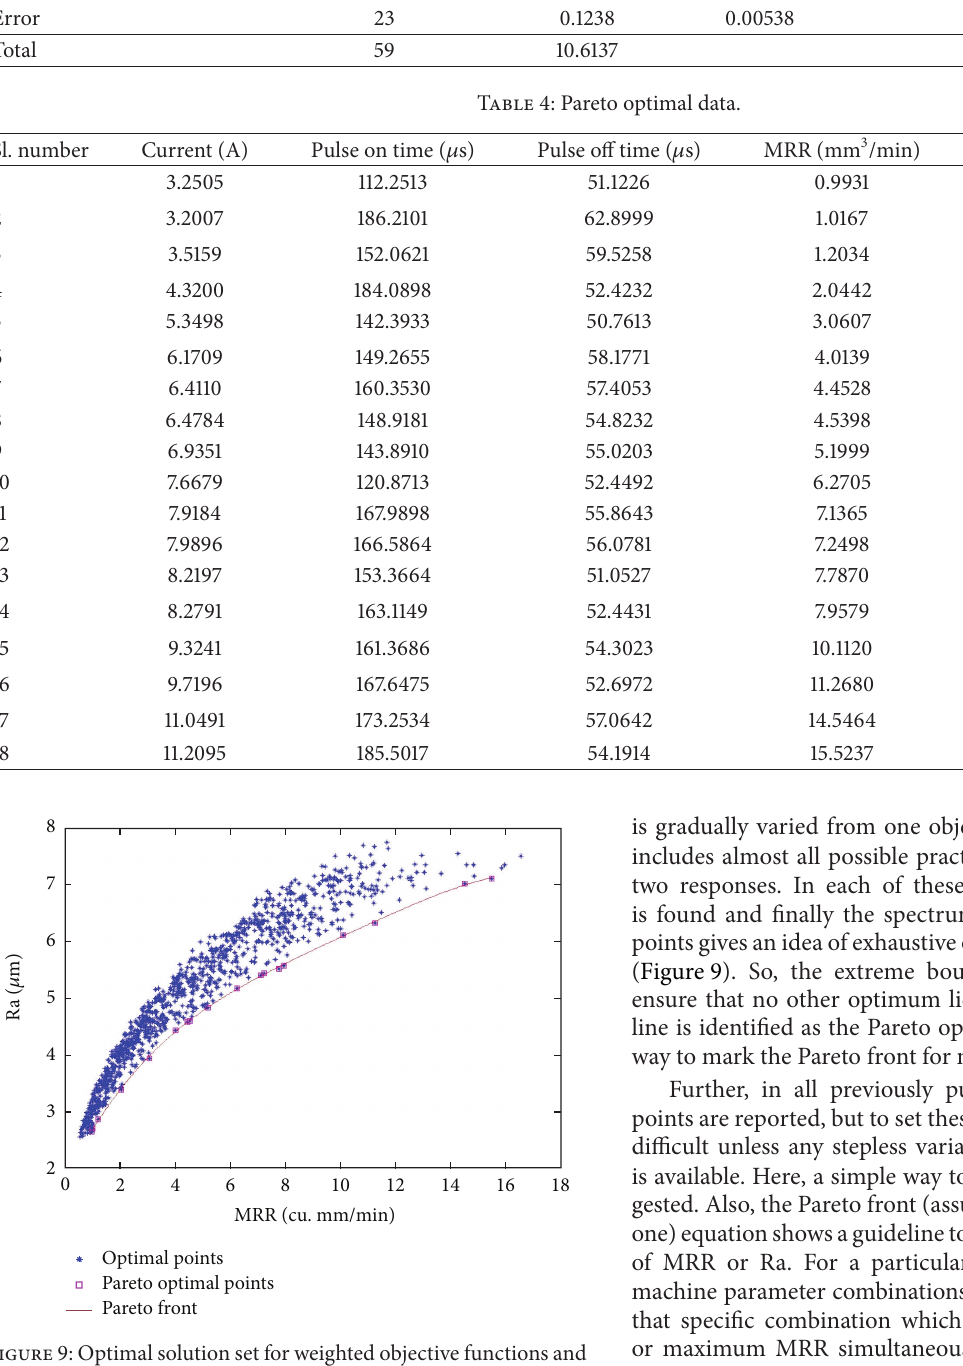
Figure 9: Optimal solution set for weighted objective functions and Pareto front ( 𝑛 = 100 , accuracy =